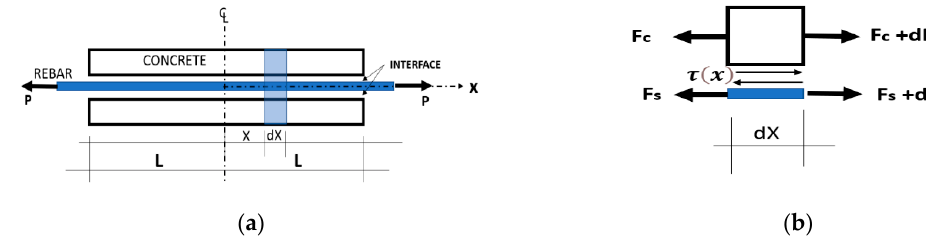
Figure 3. The differential element. ( a ) General scheme; ( b ) The differential elements. The local force is expressed by the local strain, which in turn is expressed as the derivative of the local displacements U c (x) and U s (x) , in the concrete and the steel respectively [21]. The differential equations of equilibrium for the concrete body and for the rebar are shown in Equations (2) and (3),